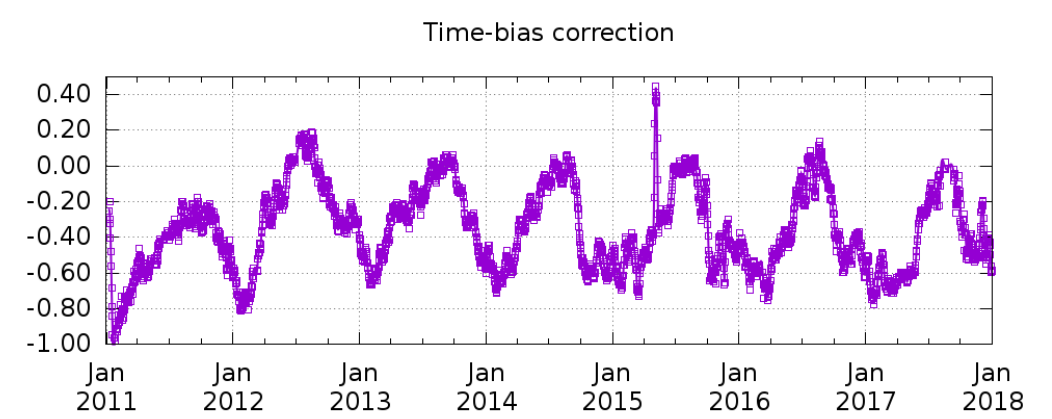
Figure 3. Time-bias correction applied to the nine-day SMOS SSS L3 maps. During 1–10 January 2011,